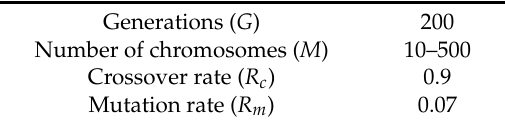
Table 4. Simulation parameters in GA.